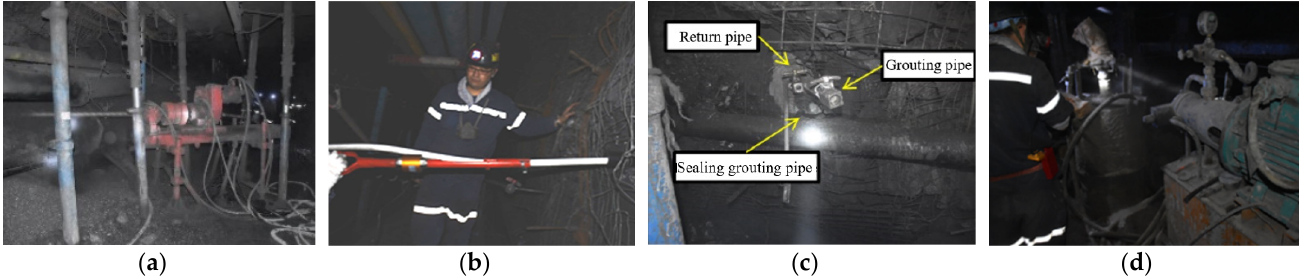
Figure 22. Application of flexible reinforcement: ( a ) grouting hole digging; ( b ) aluminum–plastic pipe installation; ( c ) grouting hole sealing; ( d ) under the shaft grouting.